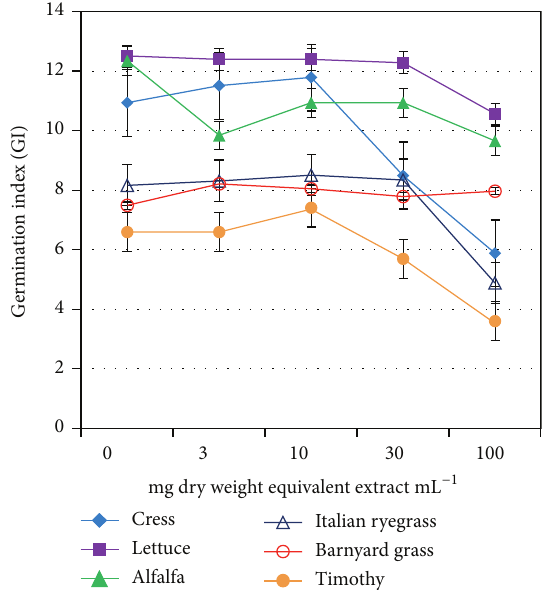
Figure 2: Effect of aqueous methanol extracts of O. tenuiflorum on GI of different plant species at four different concentrations. Other details are the same as Figure 1.